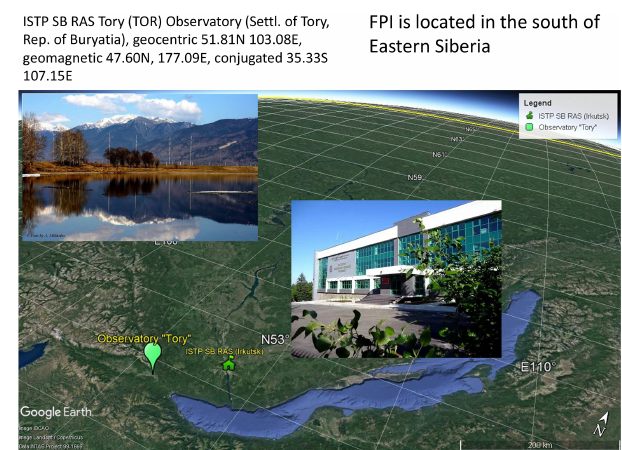
Figure 1. This © Google Earth map shows the location of the Fabry–Perot interferometer at the Tory Observatory and the Insti- tute of Solar-Terrestrial Physics